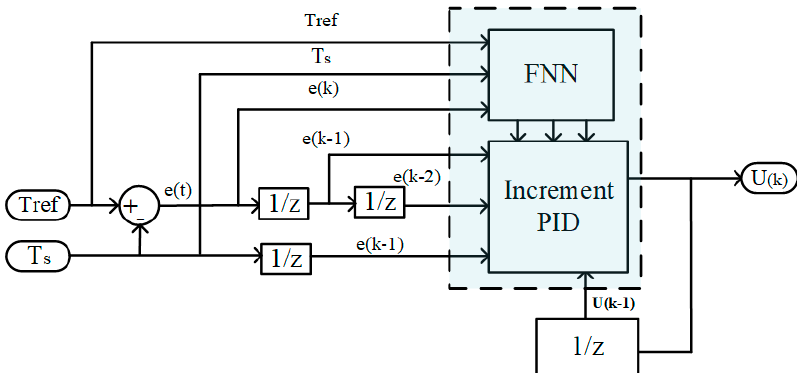
Figure 6. Neural network control structure diagram.